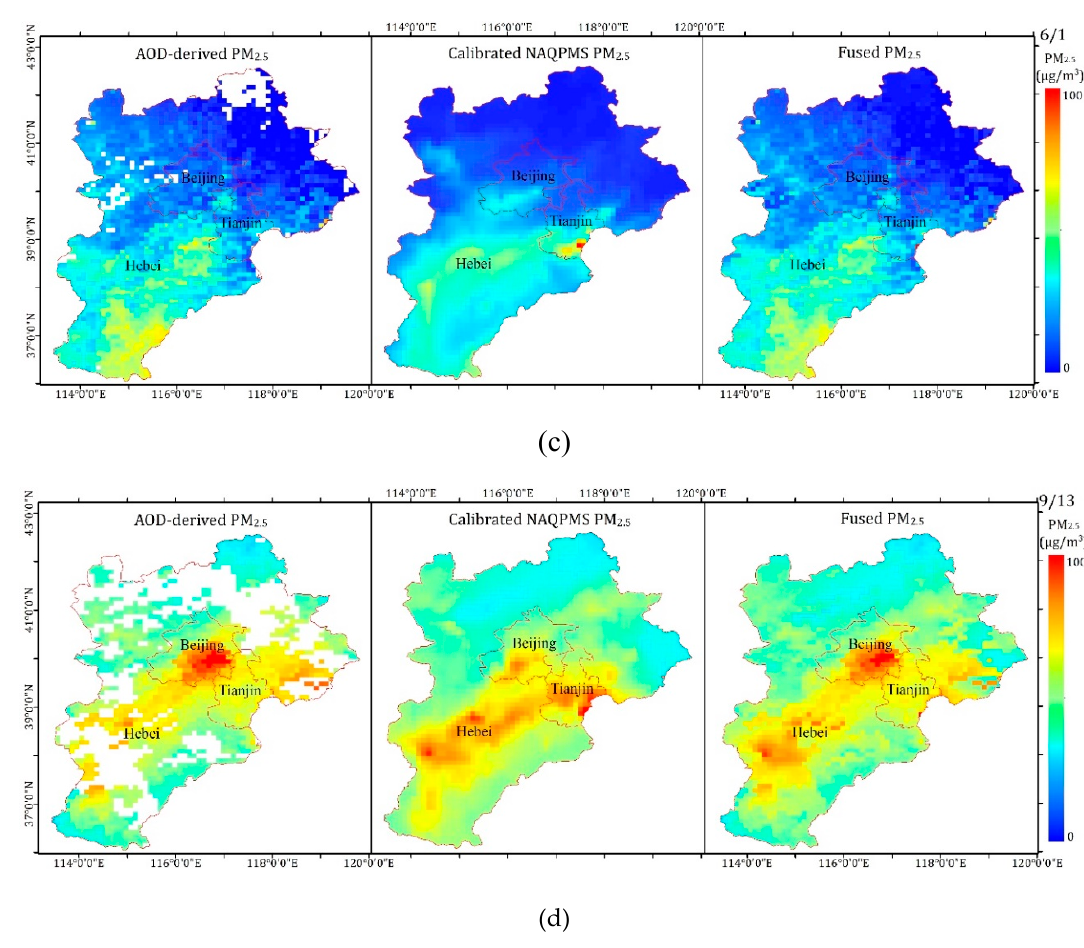
Figure 12. Spatiotemporal distributions of AOD-derived PM 2.5 , calibrated NAQPMS PM 2.5 , and fused PM 2.5 . ( a ) 27 February 2017, ( b ) 1 May 2017, ( c ) 1 June 2017, and ( d ) 13 September 2017.